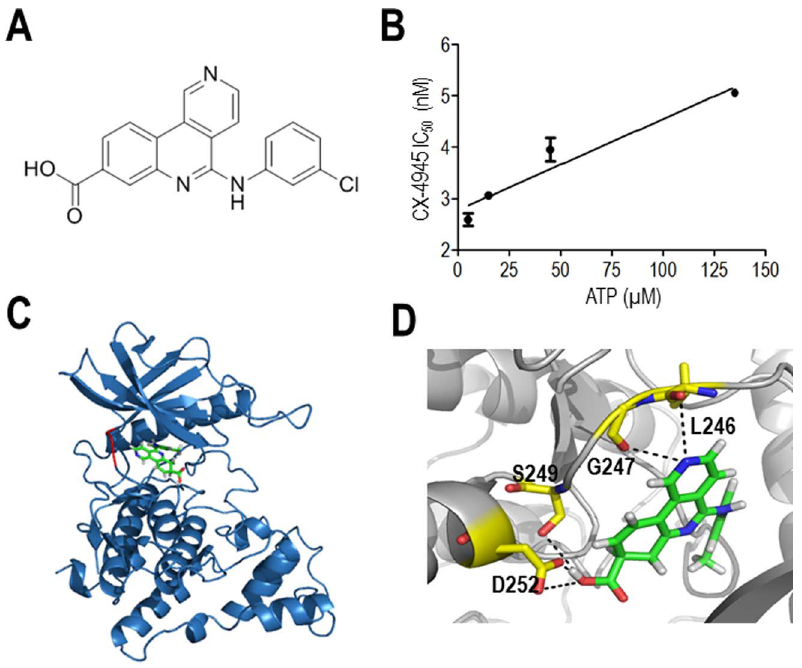
Figure 5. ATP-competitive inhibition of Clks by CX-4945. (A) Diagram of the chemical structure of CX-4945 (B) Competition of CX-4945 with ATP for inhibition of Clk2 (C) Structural model of the Clk2 in complex with CX-4945. CX-4945 was predicted to bind to the ATP-binding site of Clk2. (D) The predicted binding mode between CX-4945 and Clk2. Amino acids in the active site are denoted by yellow sticks, and CX-4945 is indicated by green sticks. Hydrogen bonds are denoted as dotted black lines, and oxygen and nitrogen atoms are indicated as red and blue sticks, respectively.